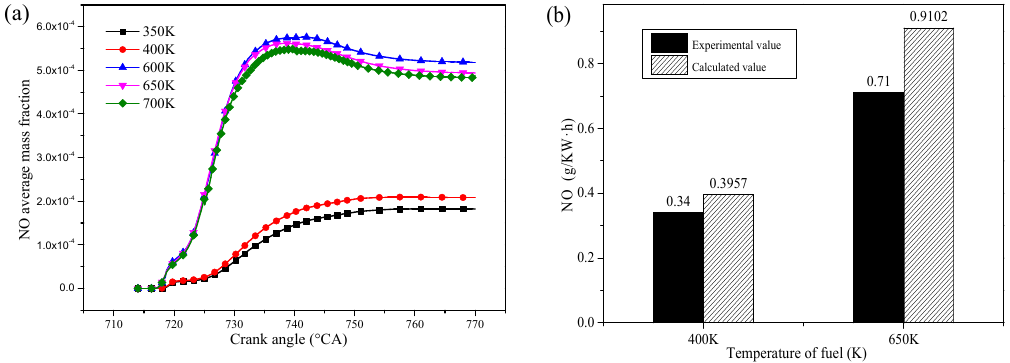
Figure 9. ( a ) Change curve of NO; ( b ) NO emission comparison average mass fraction.